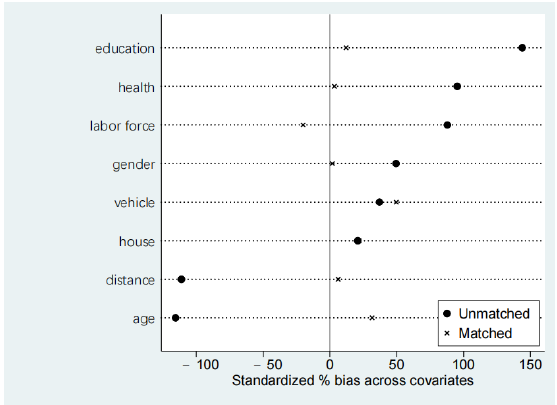
( b ) Figure 4. The density function of variables’ propensity scores of the land in-transfers group and the control group: ( a ) The density function graph of variables’ propensity scores before matching; ( b ) The density function graph of variables’ propensity scores after matching. 4.1.2. Test of Balance In order to ensure the reliability of propensity score matching results, this paper tested the balance of covariables; that is, after matching, there was no significant system- atic difference in covariables between the control group and the treatment group, except for the difference in the actual adoption of new varieties. This paper uses Rubin and Ros- enbaum’s method as a reference to test the balance in three aspects [65,66]. The standard deviation of matching variables between the treatment group and the control group be- fore and after matching was compared. The reduction in standard deviation indicated that